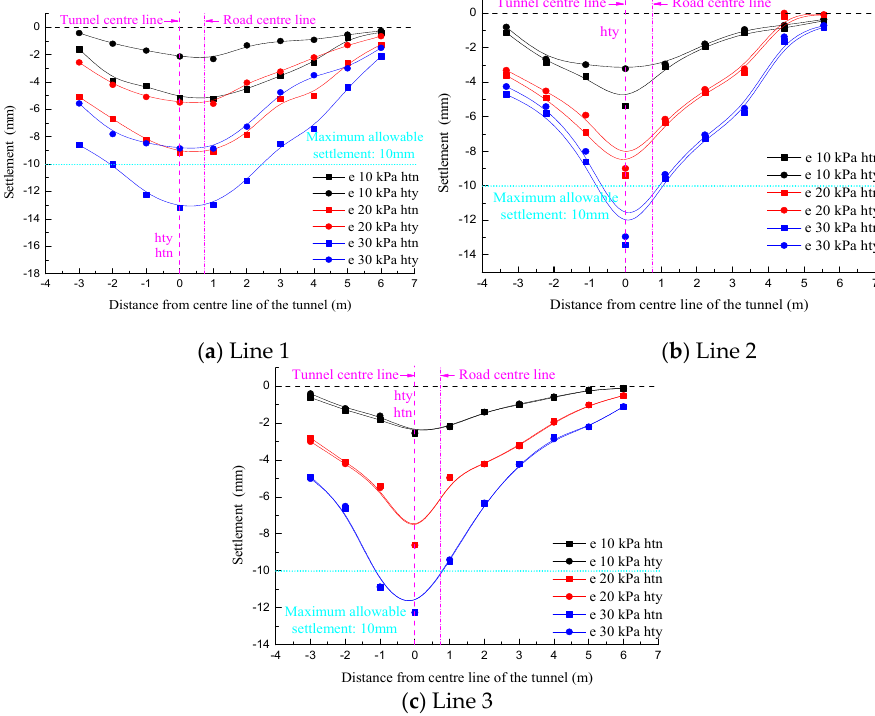
Figure 15. Longitudinal surface settlement of model E-E with D/W = 0.251.